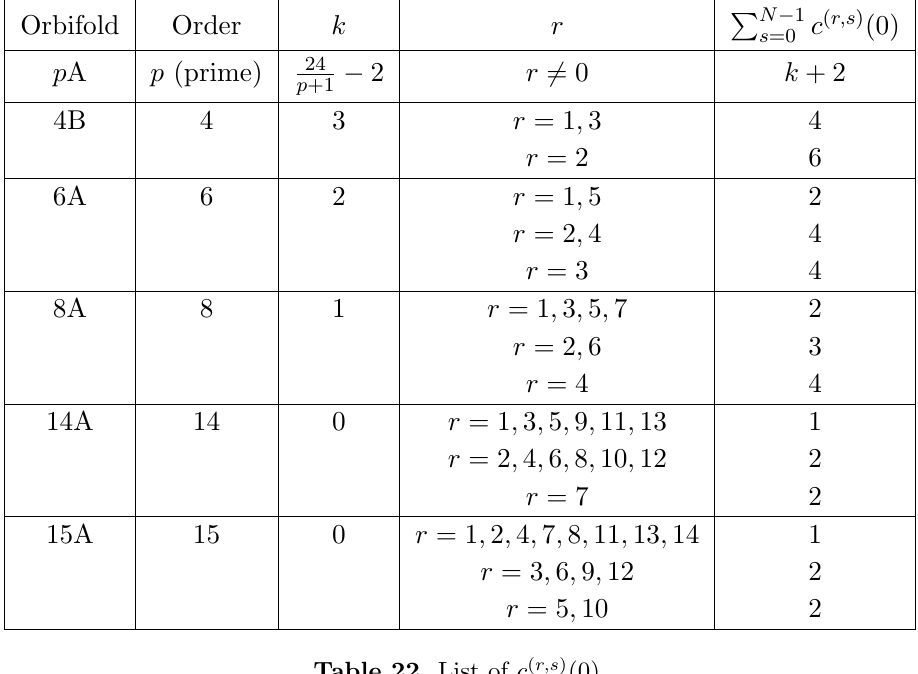
Table 22 . List of c ( r;s )